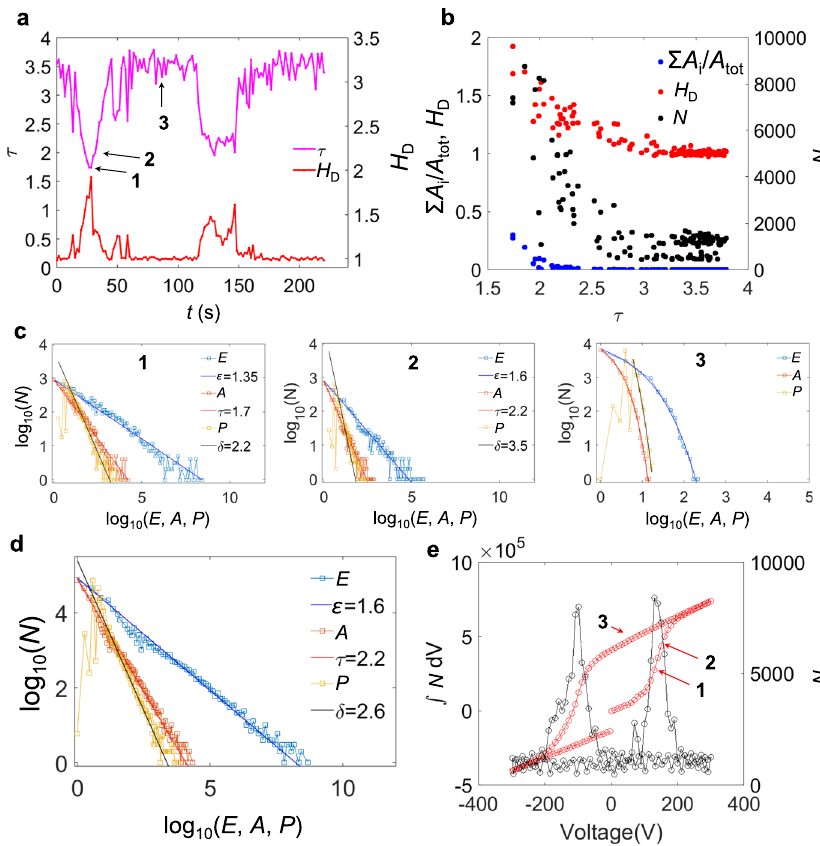
Fig. 4 Scale-invariant avalanches in BTO. a H D and τ as a function of time. b H D , Σ ( A i )/ A tot (proportion of switched regions with respect to the total area) and N (avalanche activity, de fi ned as the number of switched regions between t and t + δ t ) as a function of τ . c E (energy), A (area) and P (perimeter) distribution at the time steps marked as 1, 2 and 3 by arrows in a . d E , A and P distribution from all the time steps. e N as a function of the applied voltage (right axis) and its integration over the voltage applied (left